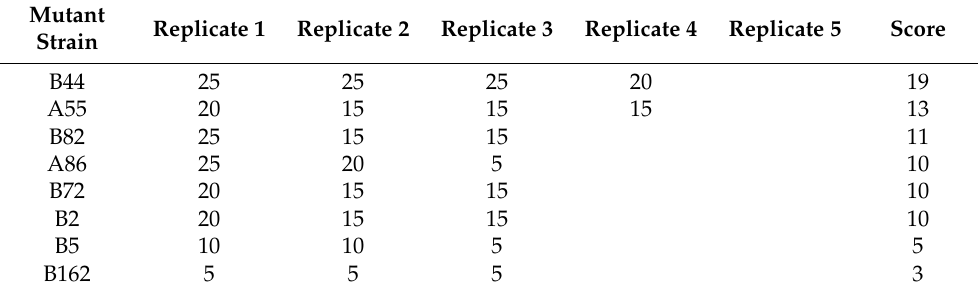
Table 3. The scoring results of screening drought-tolerant mutans.